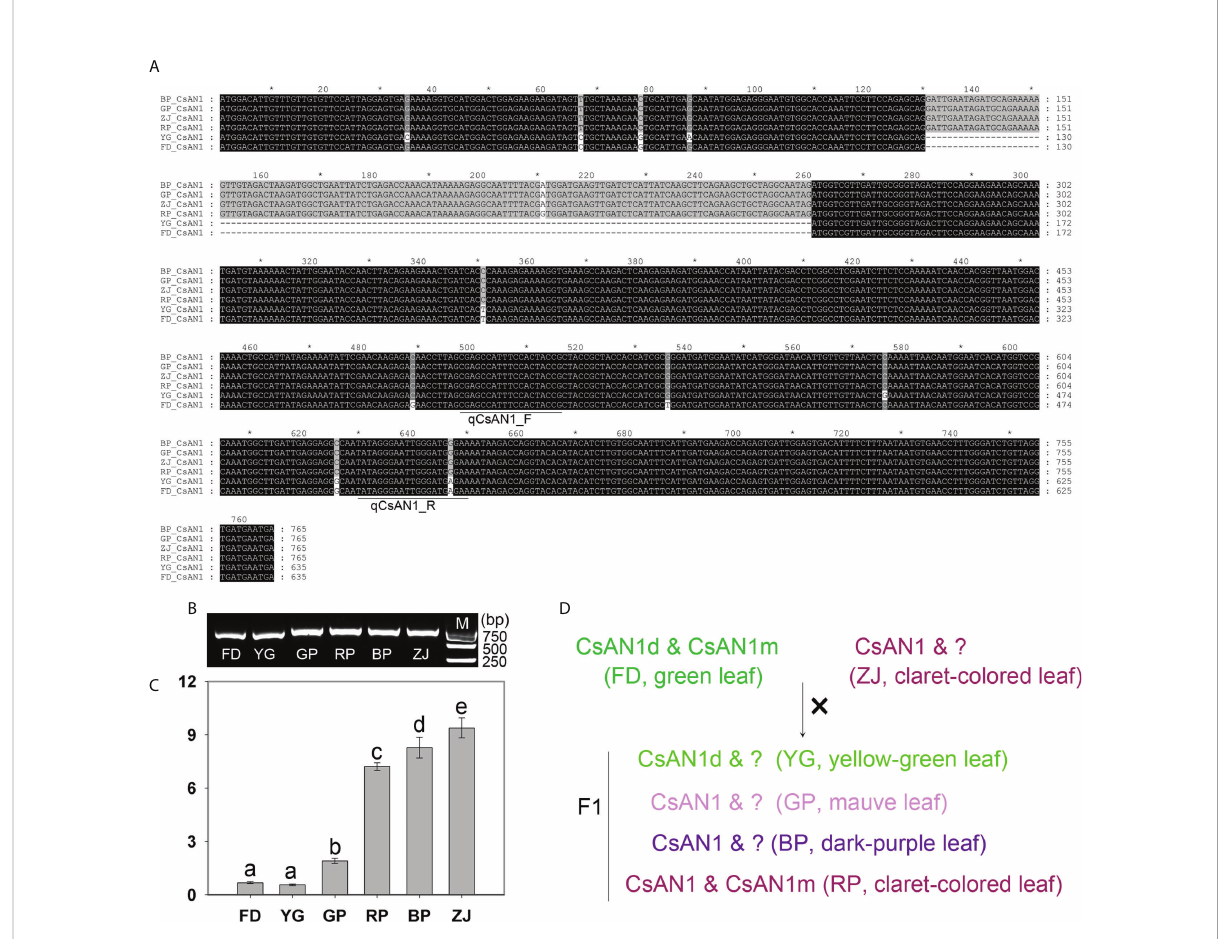
FIGURE 7 Cloning and expression analysis of CsAN1. (A) The sequence alignment of CsAN1 in the parents and F1 hybrids (the gray "*" means the numbers spaced by ten); (B) RT-PCR analysis of CsAN1 in the parents and F1 hybrids; (C) the expression pattern of CsAN1 in the parents and F1 hybrids; (D) The putative regulatoary model of anthocyanin accumulation in F1 hybrids. qCsAN1_F and qCsAN1_R was the primer pair for RT-qPCR detection. “ ? ” represented the unknown CsAN1 ortholog. Signi fi cant difference at p < 0.05 is indicated by different letters (a-e) above the